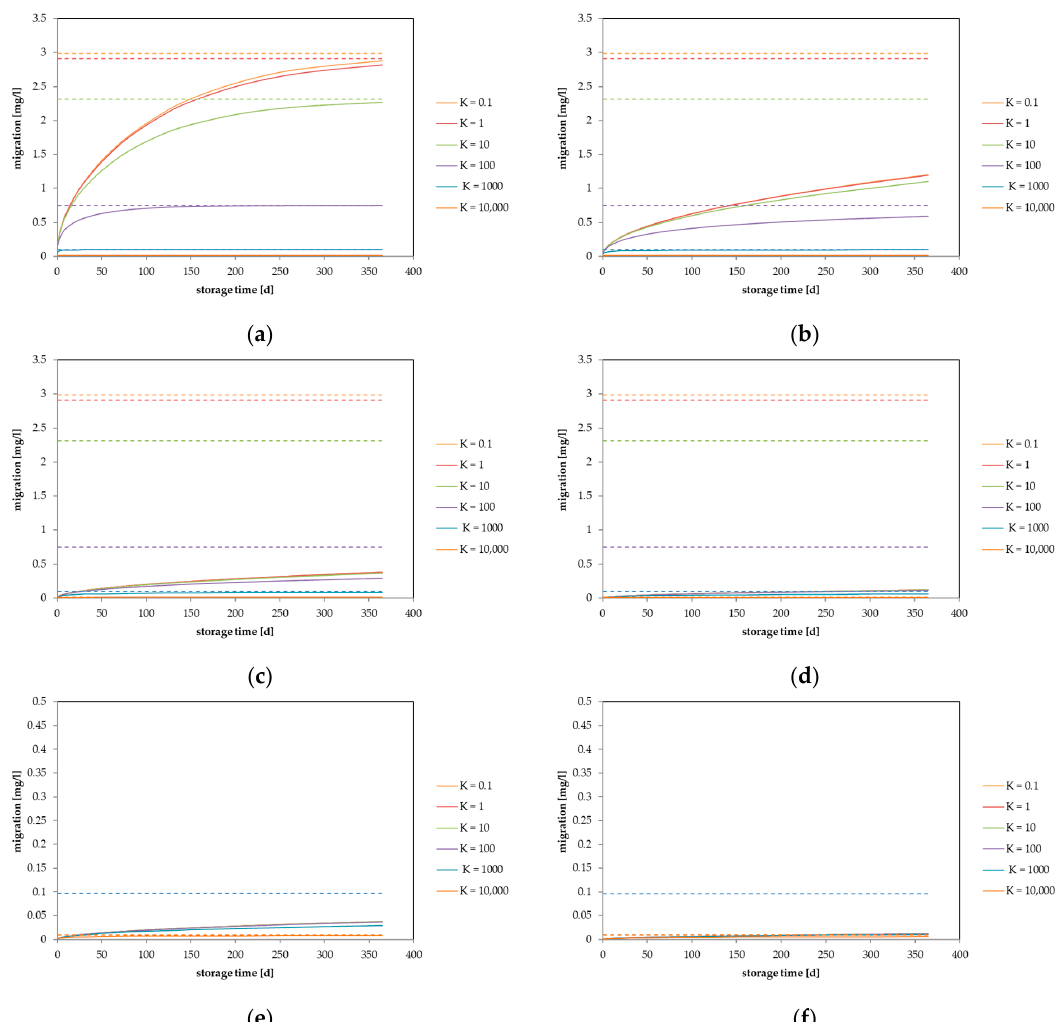
Figure 2. Calculated migration into food considering different partition coefficients: ( a ) diffusion coefficient D P = 1 ×10 − 10 cm 2 /s, ( b ) D P = 1 ×10 − 11 cm 2 /s, ( c ) D P = 1 ×10 − 12 cm 2 /s, ( d ) D P = 1 ×10 − 13 cm 2 /s, ( e ) D P = 1 ×10 − 14 cm 2 /s and ( f ) D P = 1 ×10 − 15 cm 2 /s. Calculated for a layer thickness of d = 500 µm, c P,0 = 100 mg/kg, V = 1000 mL, A = 600 cm 2 . Note: ( e ) and ( f ) different scale on